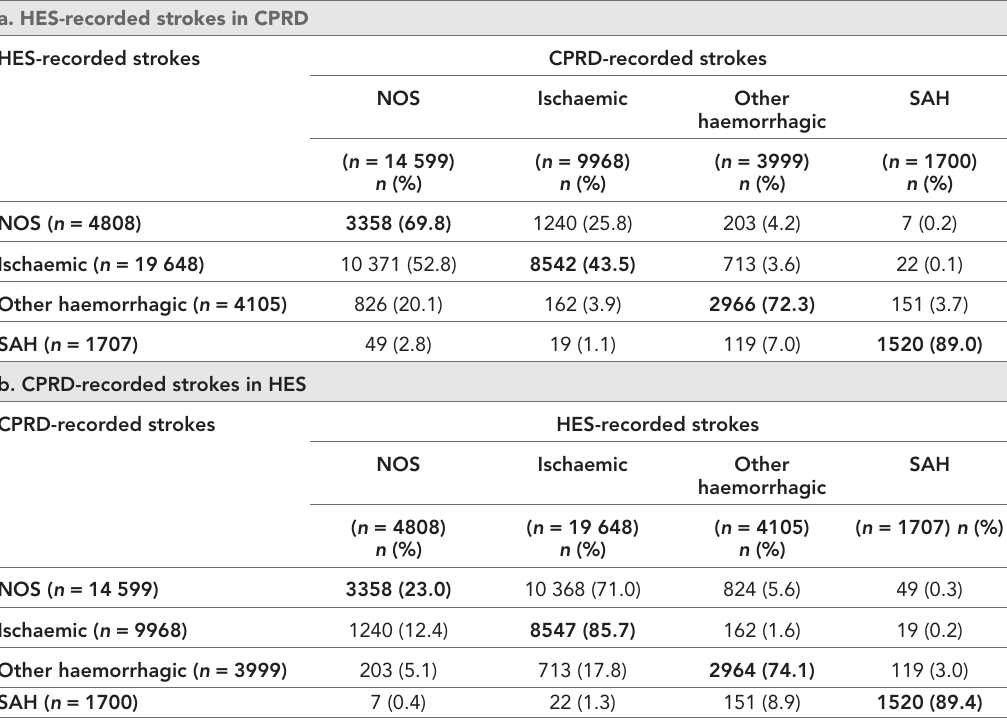
Table 2 Degree of concordance in the recording of strokes by subtype across primary and secondary care data sources